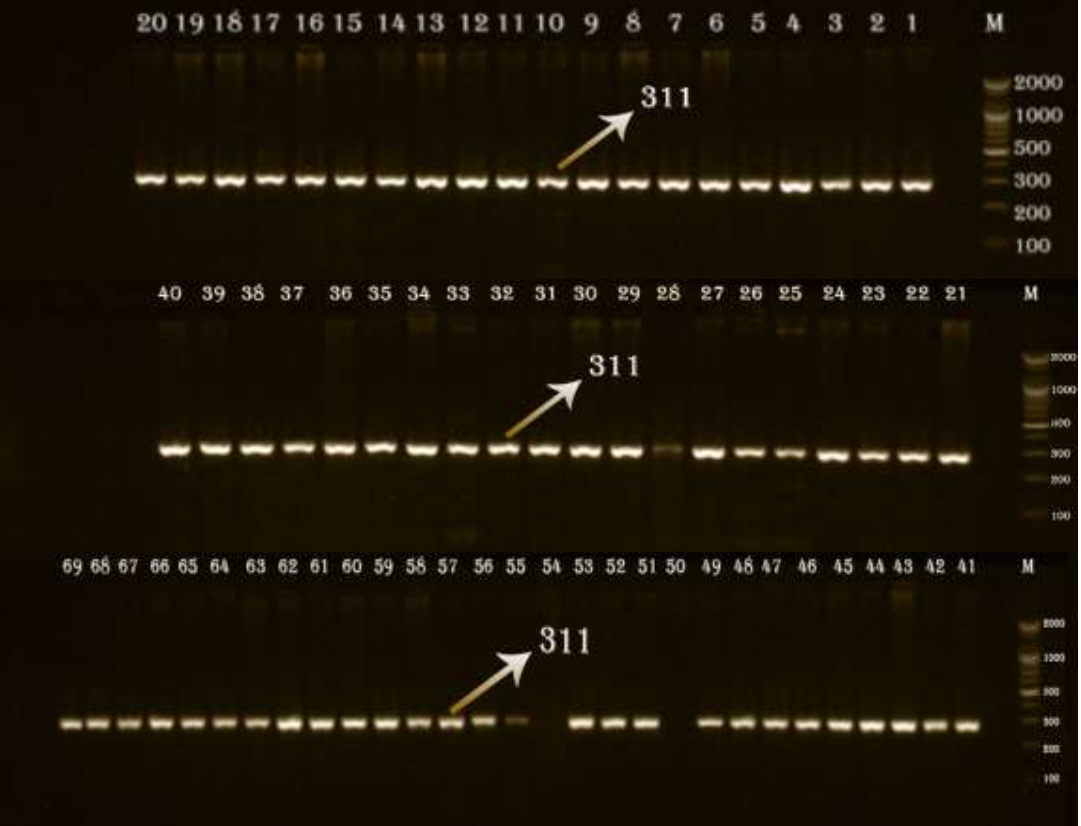
Figure (1): Electrophoresis of PCR Product of QacE gene (311 b p) in P. aeruginosa at 2% Agarose 100 volt at 60 mint Line M: DNA ladder (100 - 2000 bp), Line 1,2, 3, 4 5, 6, 7, 8, 9, 10, 11, 12, 13, 14, 15, 16, 17, 18, 19, 20,